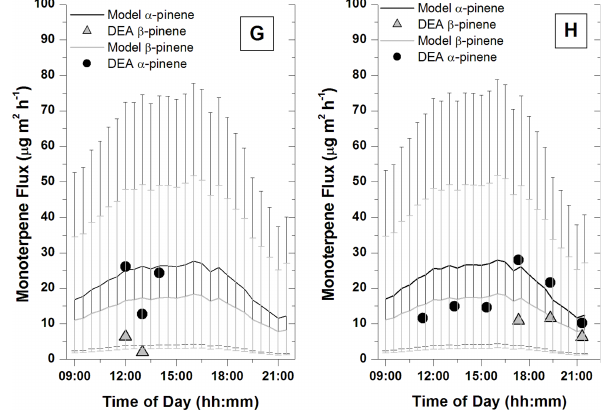
Fig. 9. Comparison of α -pinene and β -pinene concentrations to a 1- D atmospheric chemistry model. Using data measured during CAB- INEX 2009 to constrain the model, calculated concentrations of α - and β -pinene compare well with the DEA measurements on two partly sunny days tested 21 July (panel D ) and 4 August (panel H ), despite the inherently low terpene concentrations at this field site.